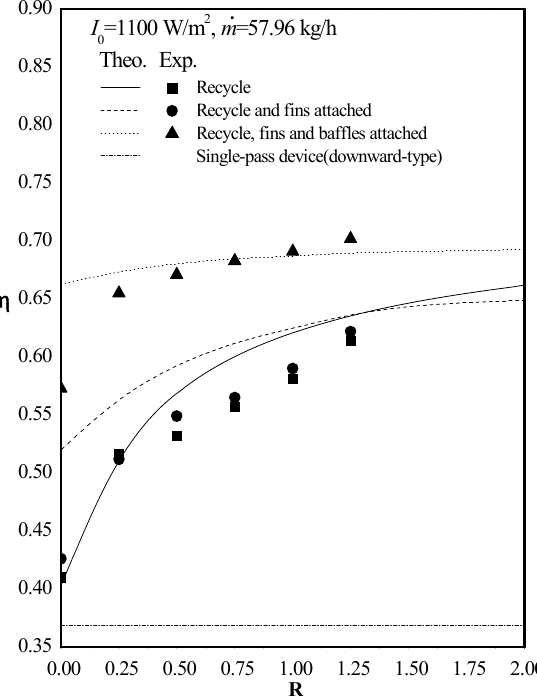
Figure 8. Effect of recycle ratio on collector efficiency in a double-pass flat-plate solar air heater with recycle; I = 1100 W/m 2 , m  = 57.96 kg/h. 0